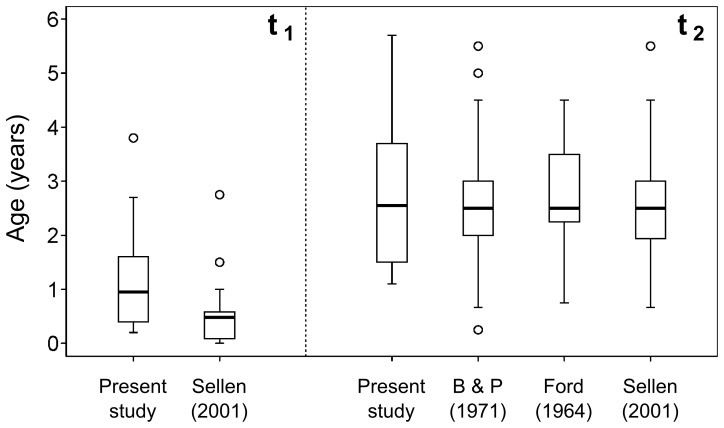
Boxplots for the weaning ages estimated in this study and observed in previous ethnographic studies.Data were obtained from Barry and Paxson (1971): [88], Ford (1964): [7], and Sellen (2001): [89].